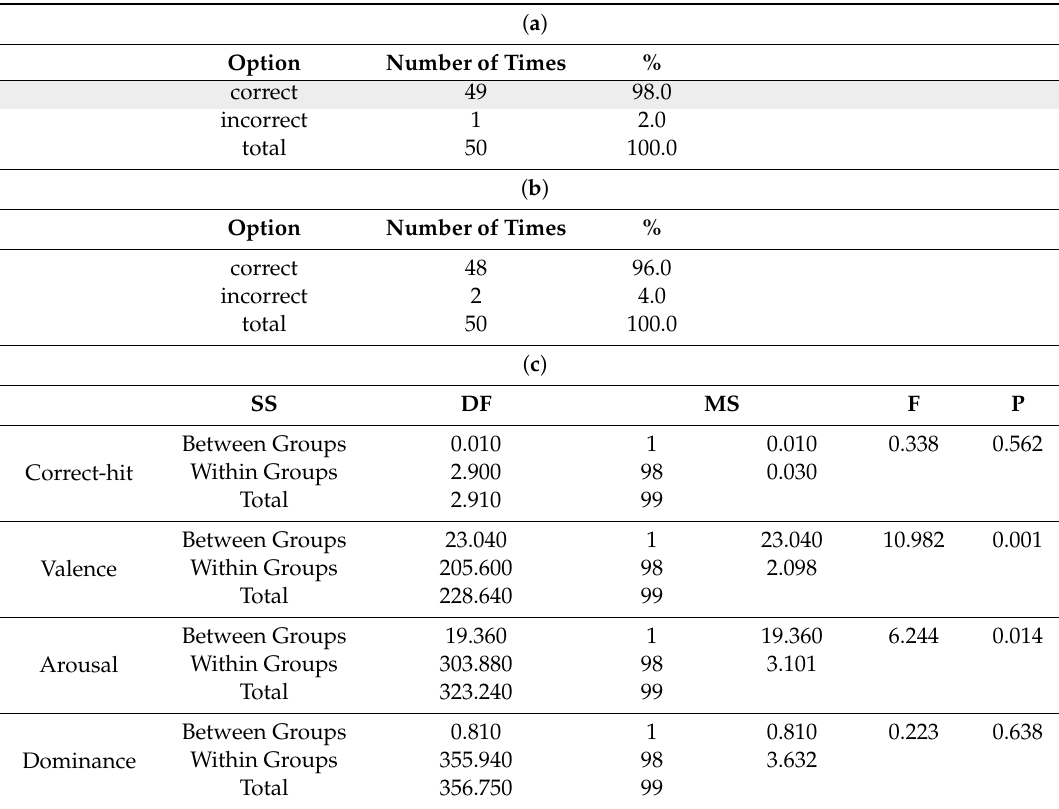
Table 4. ( a ) Usability assessment of the recharging task with the physical product. ( b ) Usability assessment of the recharging task with the virtual prototype. ( c ) ANOVA for usability assessment of the recharging